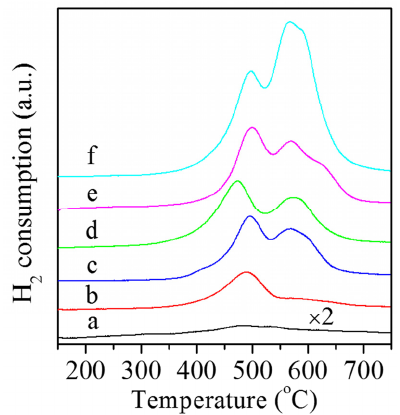
Figure 6. H 2 ‐ TPR (temperature ‐ programmed reduction) profiles of V/SBA catalysts with different vanadium content. ( a ) 1% V/SBA; ( b ) 3% V/SBA; ( c ) 5% V/SBA; ( d ) 7% V/SBA; ( e ) 7% V/MCM; ( f ) 11% V/SBA.